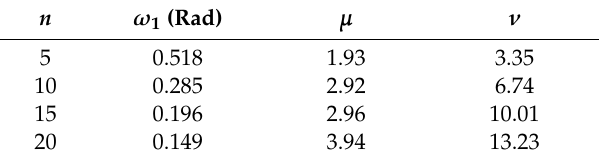
Table 6. Parameters of the numerical simulations for structures with different number of degree of freedom.